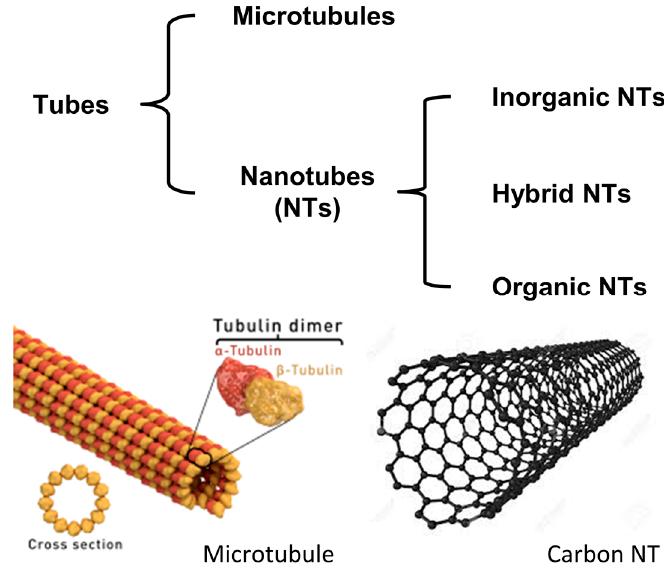
Figure 1. Classification of tubular objects, and a schematic representation of a biological tubule (micrometer scale), and of a single-walled carbon NT (SWCNT) (nanometer scale).